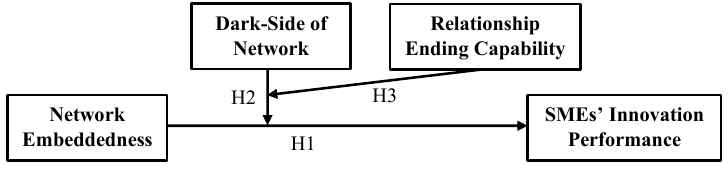
Fig. 1 – Theoretical framework. Source: own